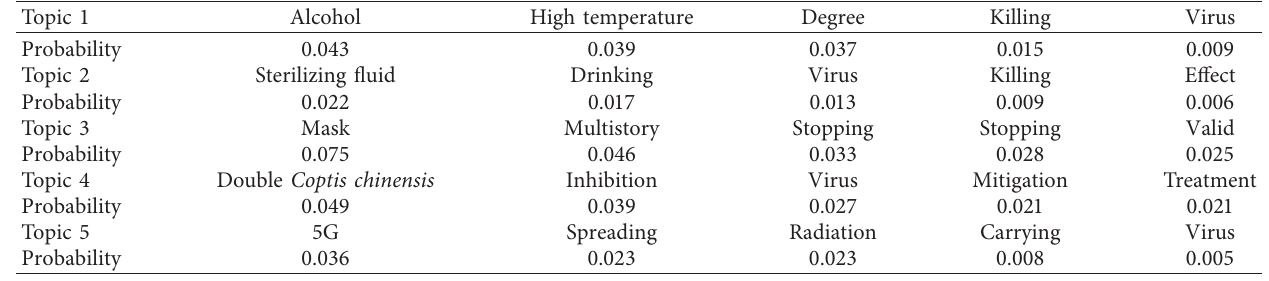
Figure 2: Perplexity-topic line chart. Table 3: Distribution of subject